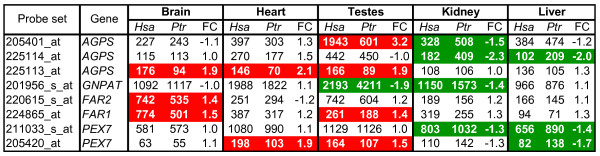
Differential expression of genes related to ether phospholipid metabolism. We provide data from the reanalysis of previously published Affymetrix GeneChip U133v2.0 expression profiles of human and chimpanzee tissues [70]. We used moderated F-tests (false discovery rate (FDR)) adjusted using the Benjamini and Hochberg approach) to test for differences in the distributions by species for the five tissues. Only probe sets with a ≤5% FDR are shown. Geometric mean expression scores are provided for human (Hsa) and chimpanzee (Ptr) tissues. FC: fold change of Hsa relative to Ptr expression. Transcript data are highlighted in red (up in human) or green (up in chimpanzee) if they show ≥1.2 FC (absolute value) with a moderated t-test P-value ≤0.05 after Bonferroni correction. Affymetrix probe sets IDs are provided.